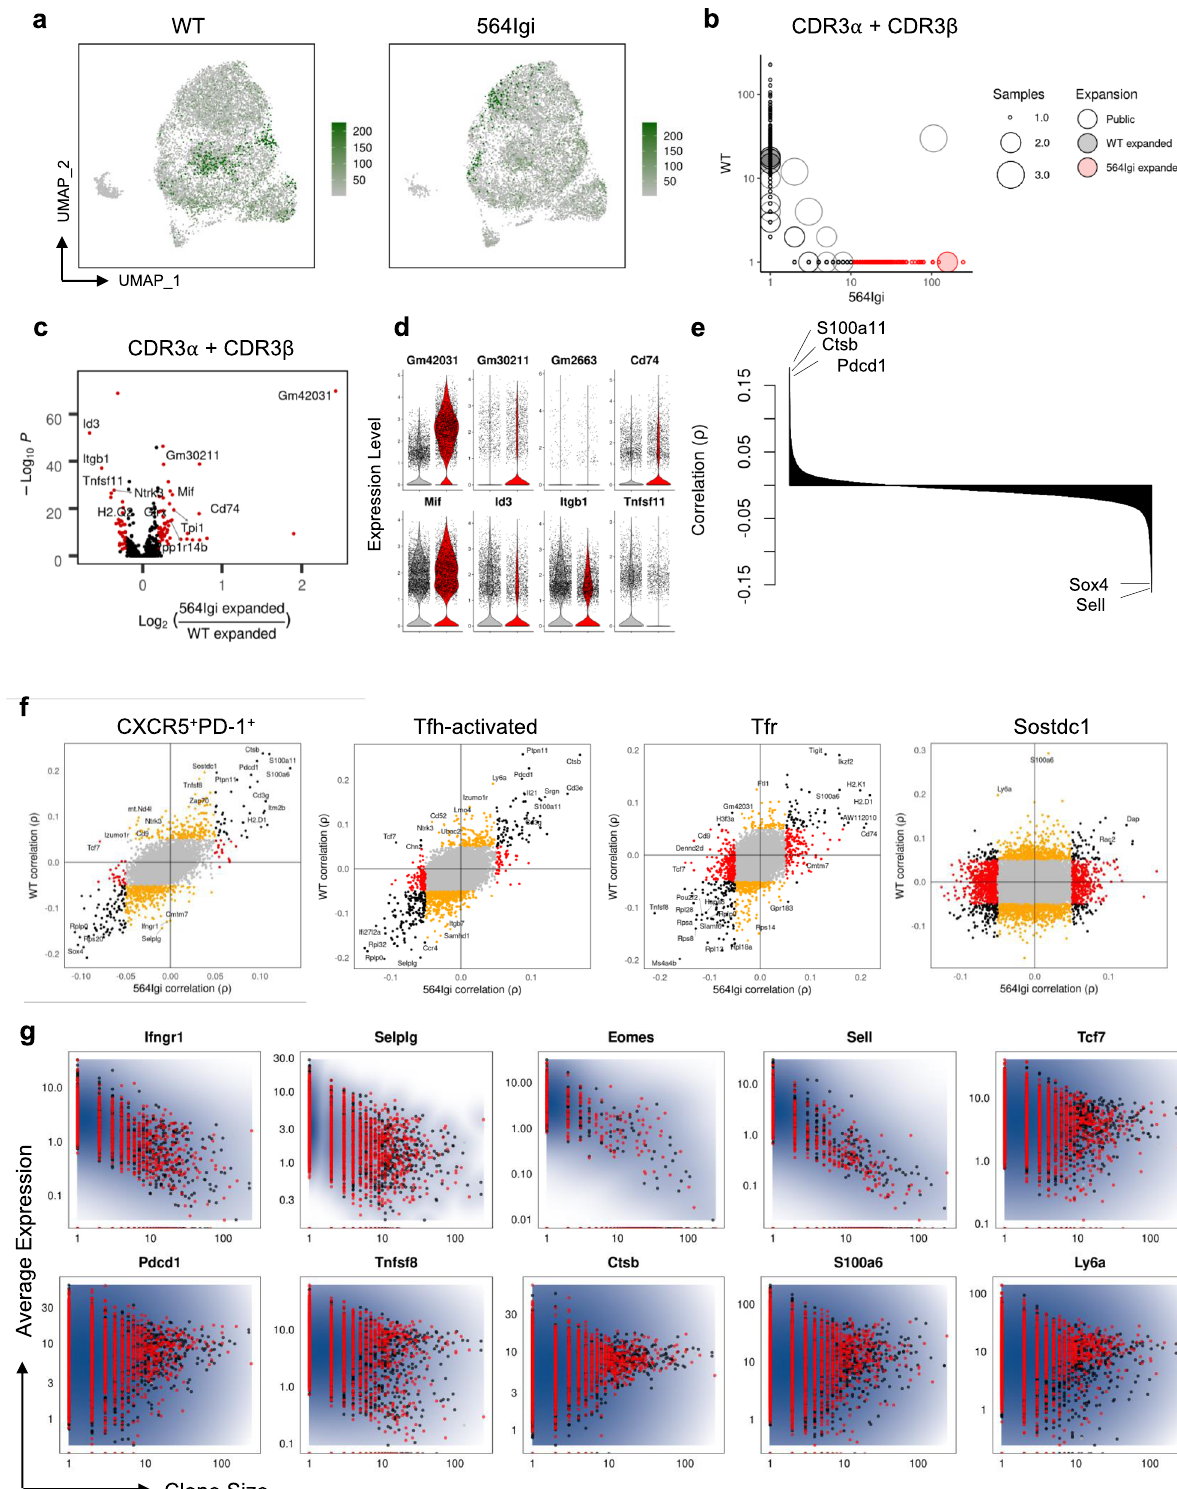
Machine learning predicts follicular T cell reactivities . To reveal the antigen speci fi city of unknown TCR sequences, we queried the VDJdb 16 , PIRD 17 , and McPAS-TCR 18 databases of known CDR3 β speci fi cities. We compiled all three databases to create a single reference database consisting of 99,809 unique CDR3 β sequences with annotated speci fi cities for 469 antigens and 482 peptides from 105 different diseases or